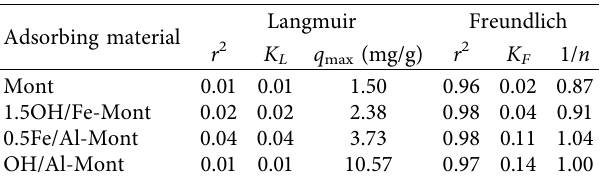
Figure 11: Relationship diagram between adsorption capacity and equilibrium concentration of ZEA. Table 2: Model parameters of both Langmuir and Freundlich adsorption isotherms for ZEA.